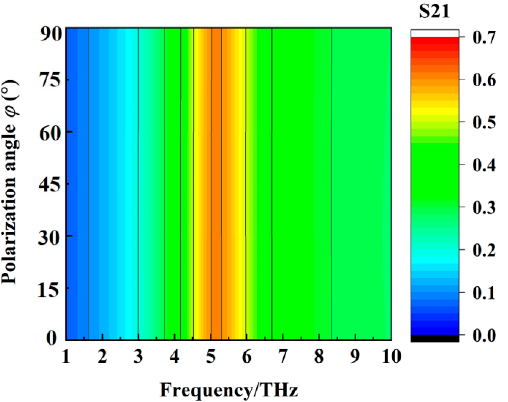
VO 2 film is 2 × 10 5 S/m at different polarization angles.